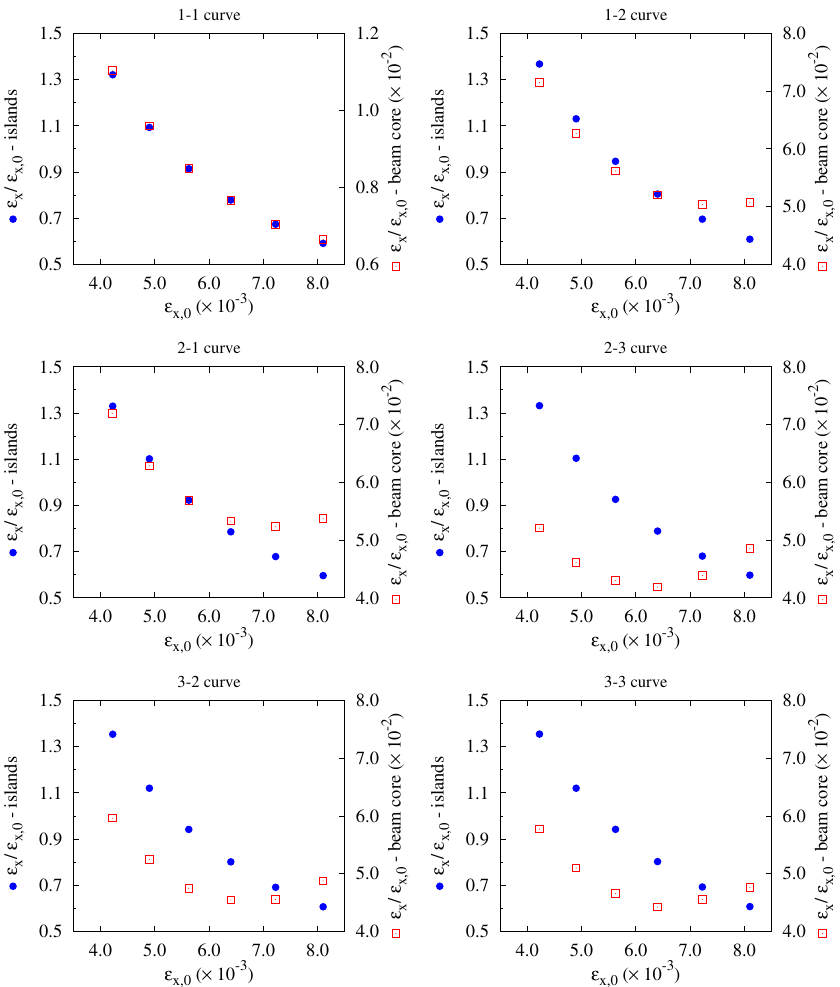
FIG. 6. (Color) Relative islands emittance as a function of the initial emittance. Six types of tune curves are used (marked on top of each